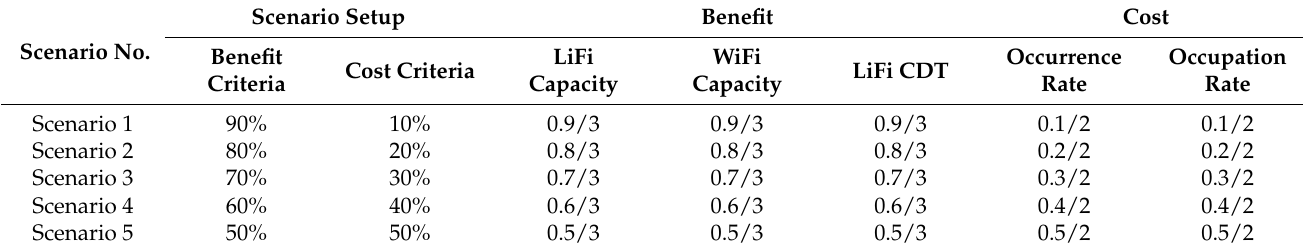
Table 24. New weight values for each criterion of five scenarios.